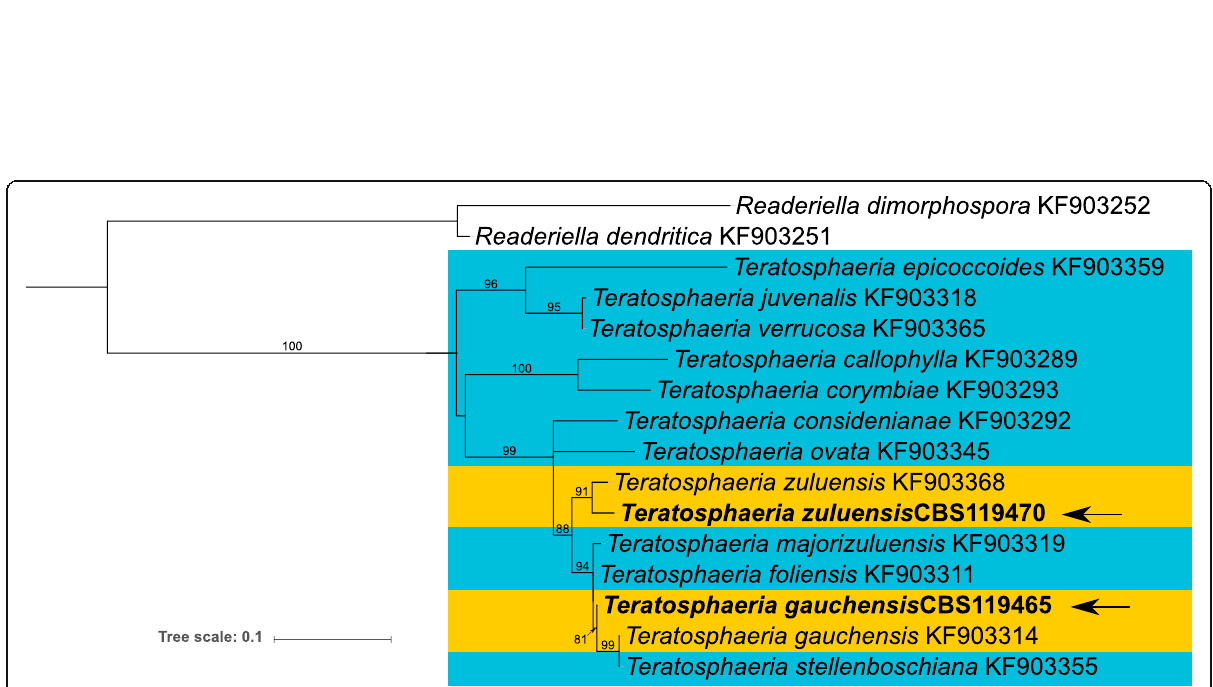
Fig. 3 Maximum Likelihood phylogeny of the Teratosphaeria stem canker pathogens and related species based on the Elongation Factor (EF1- α ) gene. Leaf-associated species are highlighted in teal, whereas the stem canker pathogens are yellow. The genome isolates described in this study are indicated with arrows. GeneBank accessions are shown after the species